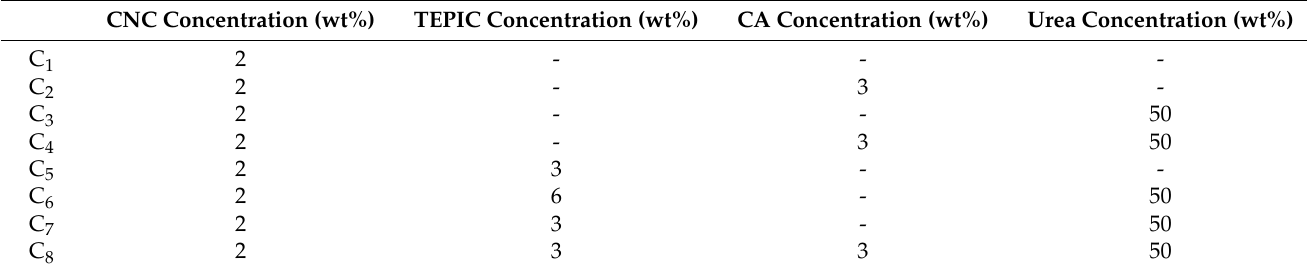
Table 1. The CNC, TEPIC, CA, and Urea content percentage for each treatment